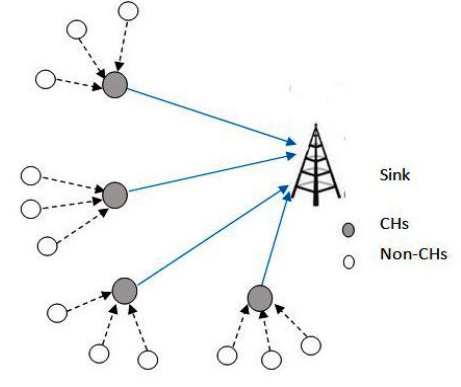
Figure 1. Data Routing via Cluster head